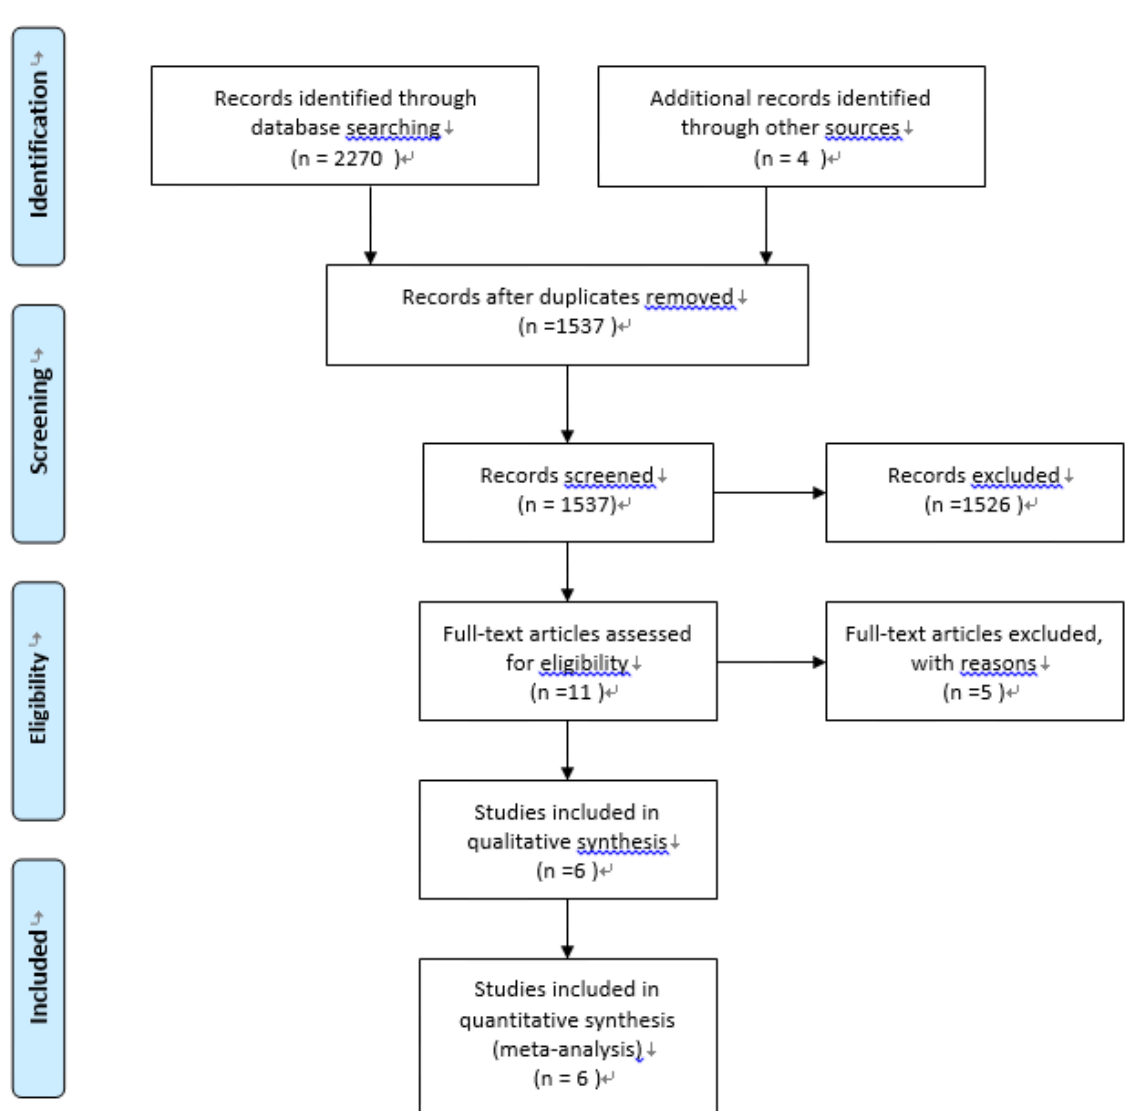
Figure 1. Preferred Reporting Items for Systematic Reviews and Meta-Analyses (PRISMA) Flow Diagram.